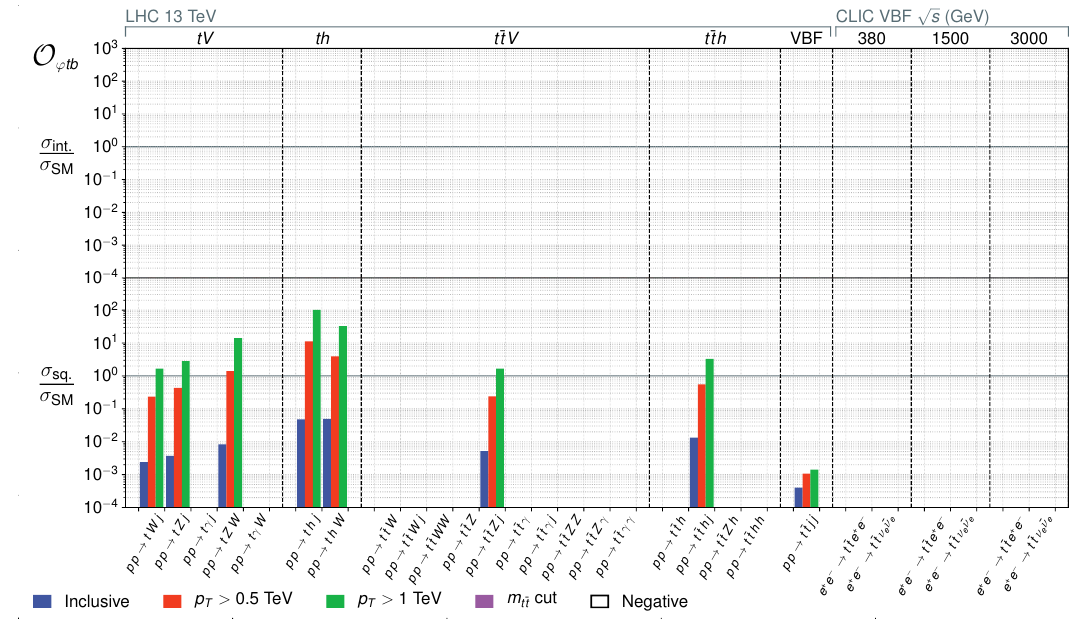
Figure 46. Same as (cid:12)gure 40 for